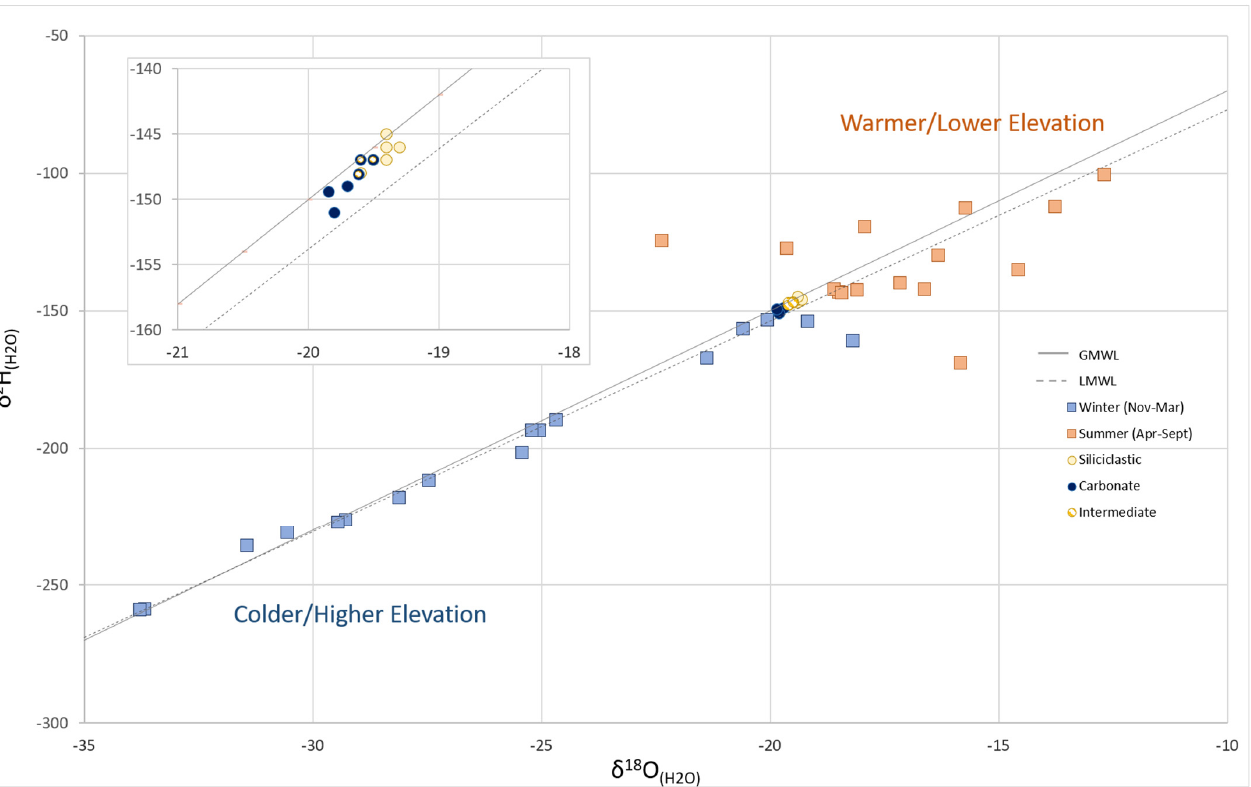
Figure 6. Cross plot of δ 18 O and δ 2 H in precipitation (filled squares; from Campbell et al. [16]) and longitudinal streamflow samples (circles). The global meteoric water line (solid grey) and local meteoric water line (dashed grey, from Peng et al., 2004 [52]) are shown. Colder and/or higher-elevation precipitation has lower δ 18 O and δ 2 H values (blue squares) and warmer and/or lower-elevation precipitation has higher values (orange squares). Siliciclastic-stored streamflow (yellow circles) falls in the warmer/lower-elevation region and carbonate-stored streamflow (blue circles) in the colder/higher- elevation region. Inset shows details of streamflow samples.